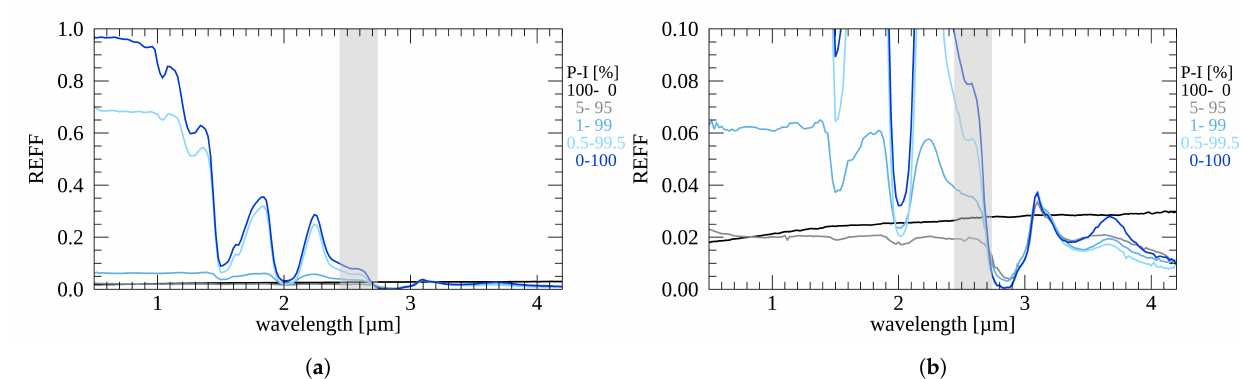
Figure 8. ( a ) Water ice–pyrrhotite < 25 intraparticle mixture spectra. Mass fractions are indicated (P: Pyrrhotite, I: Water ice). ( b ) Zoom at low reflectances. The light gray bands indicate a spectral region where possible residual water vapour contamination in the optical path may affect the resulting spectra.